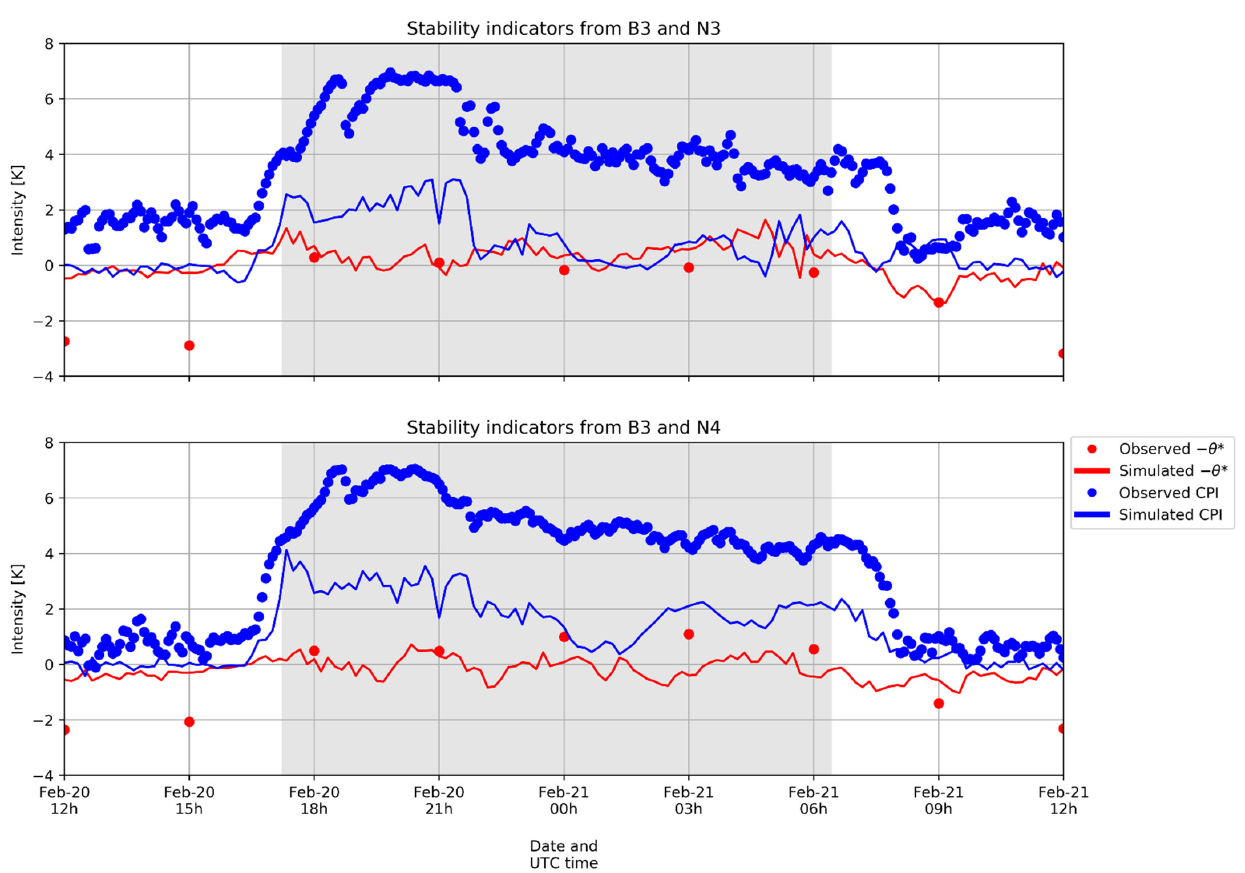
Figure 10. Time series of CPI and θ * parameters, observed (dots) and simulated (lines). The LEMS used to represent the top of the CV flank is either N4 (bottom), which is the highest station but located on an isolated hill, or N3 (top), which is at the top of the cross-valley instrumented axis (see Figure 2 for the location).